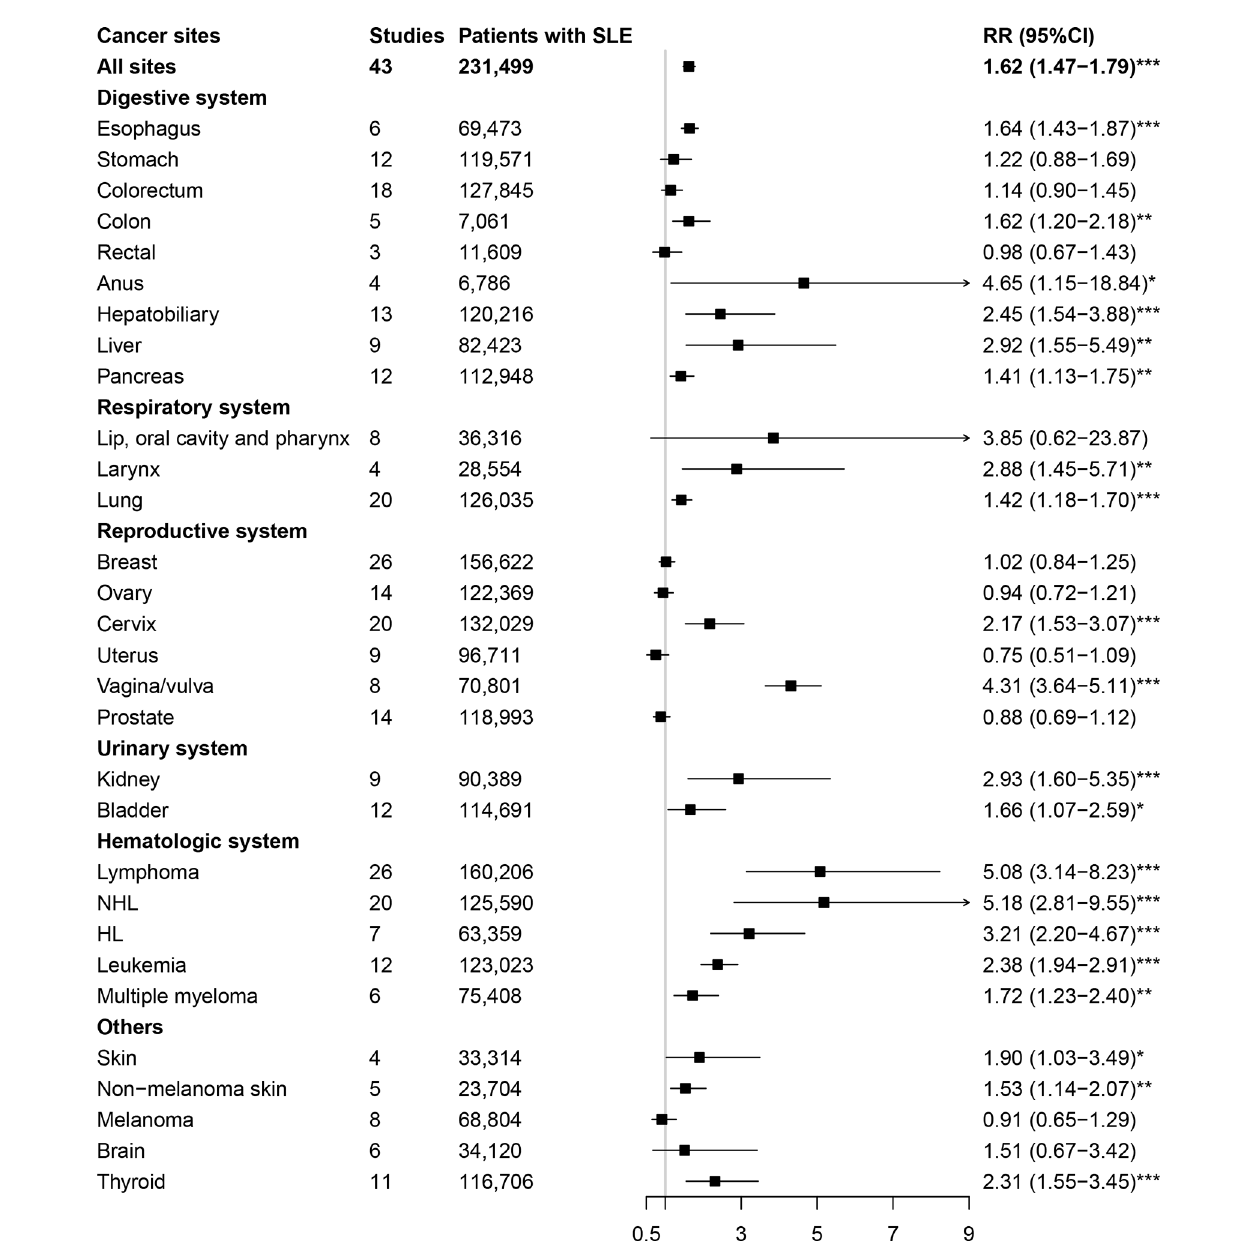
FIGURE 2 | Overall cancer and site-speci fi c cancer risk in patients with systemic lupus erythematosus. SLE, systemic lupus erythematosus; NHL, non-Hodgkin lymphoma; HL, Hodgkin lymphoma. * P -value < 0.05; ** P- value < 0.01; *** P -value <